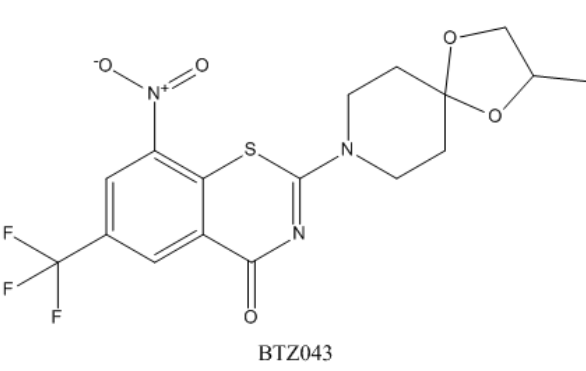
Figure 5. Structure of